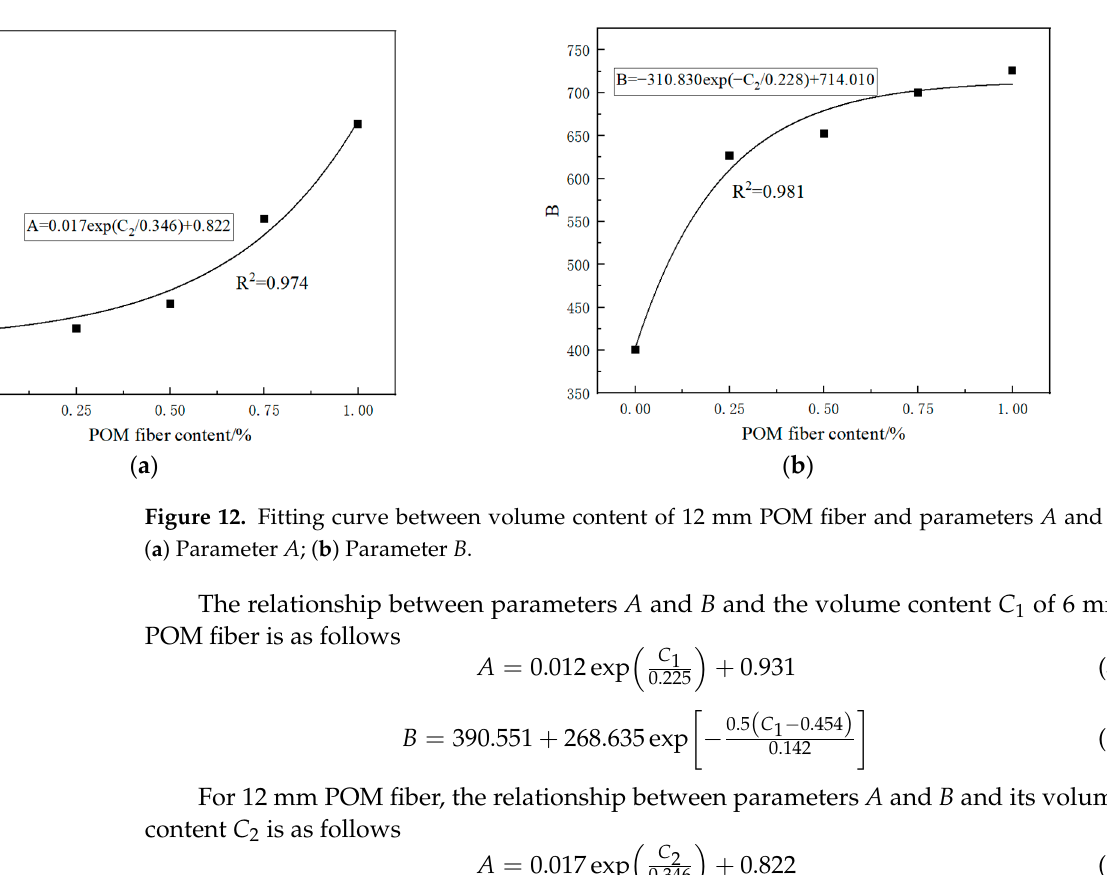
Figure 11. Fitting curve between volume content of 6 mm POM fiber and parameters A and B : ( a ) Parameter A ; ( b ) Parameter B .